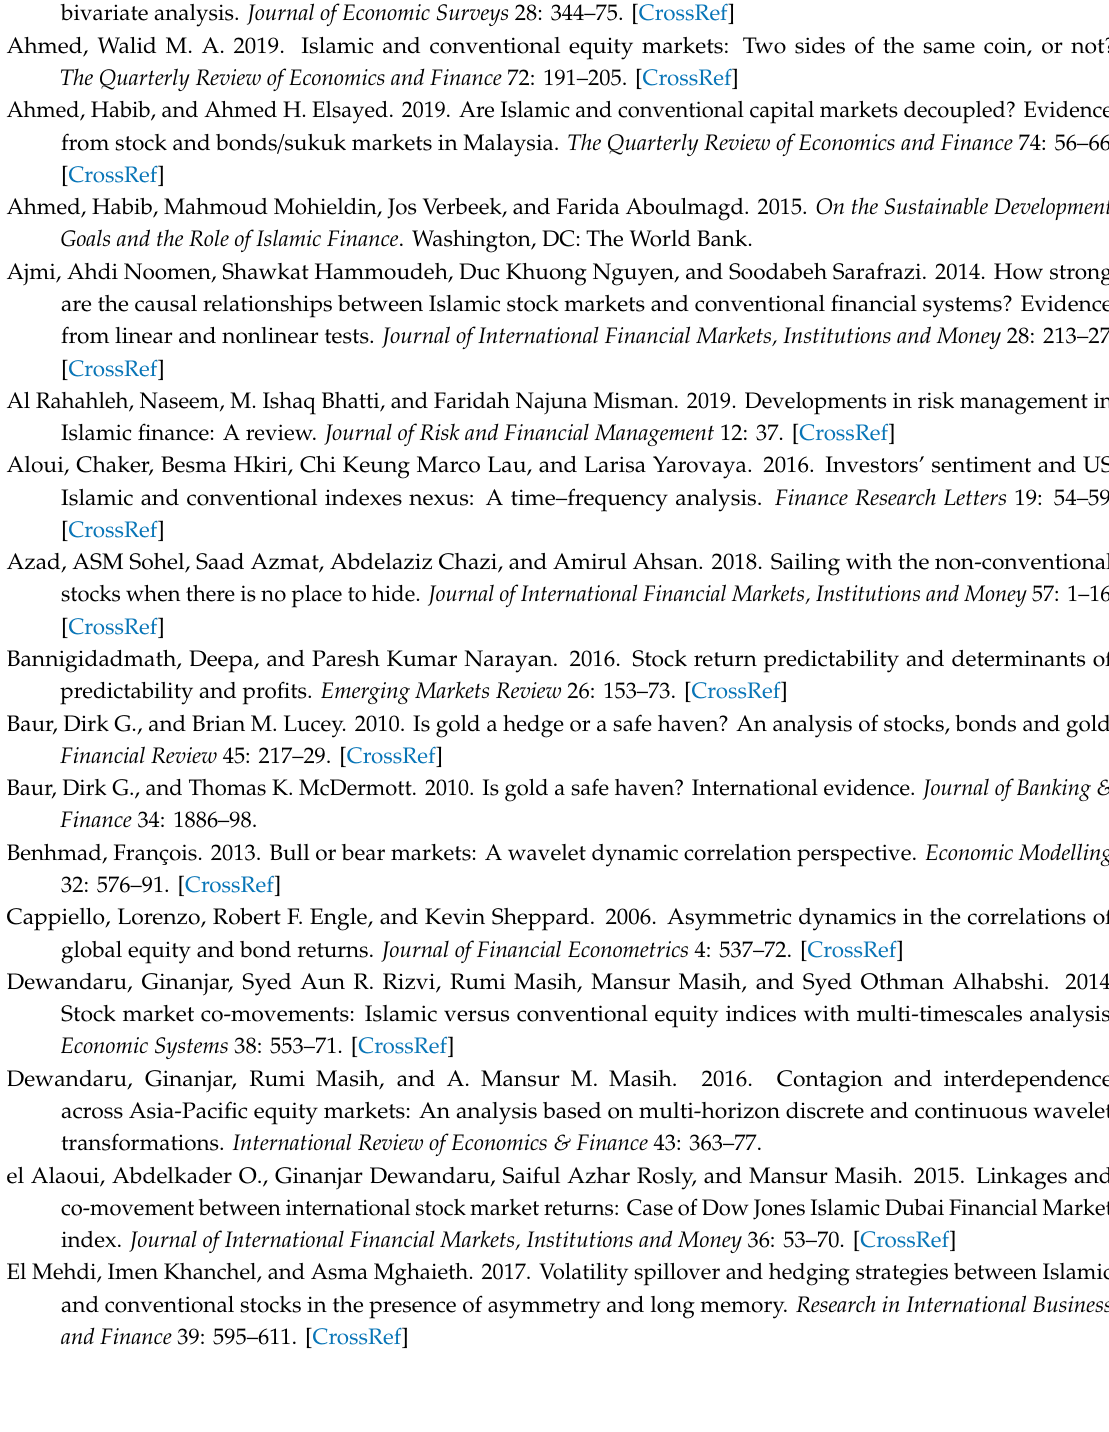
Table A3. Parameter Estimates of China’s Islamic-conventional ADCC-GARCH